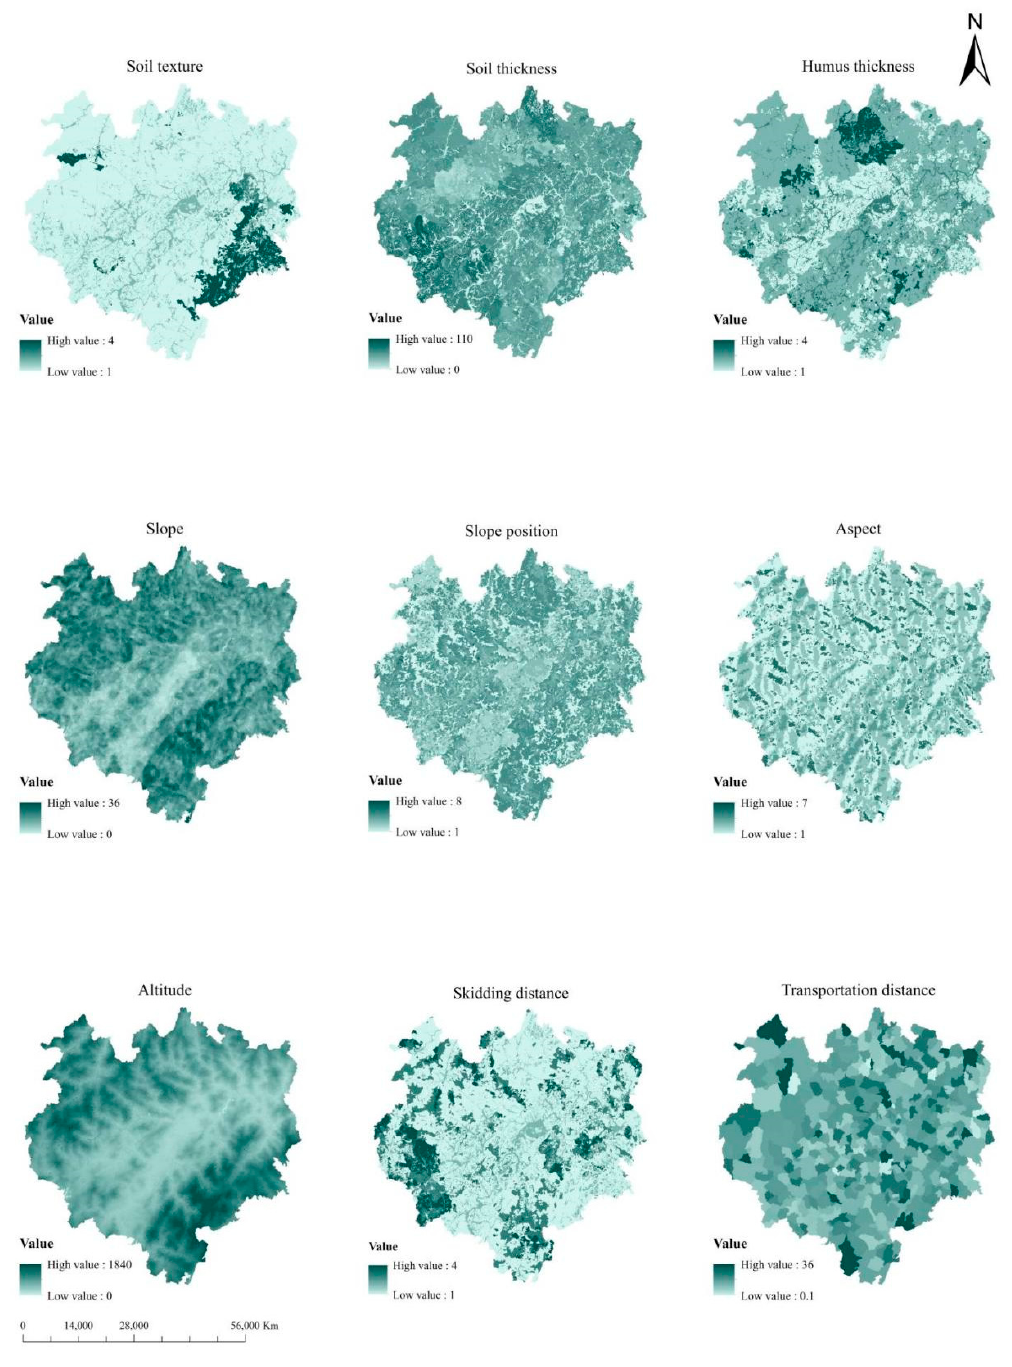
Figure 2. Rasterized diagram of each environmental and socio-economic variable.